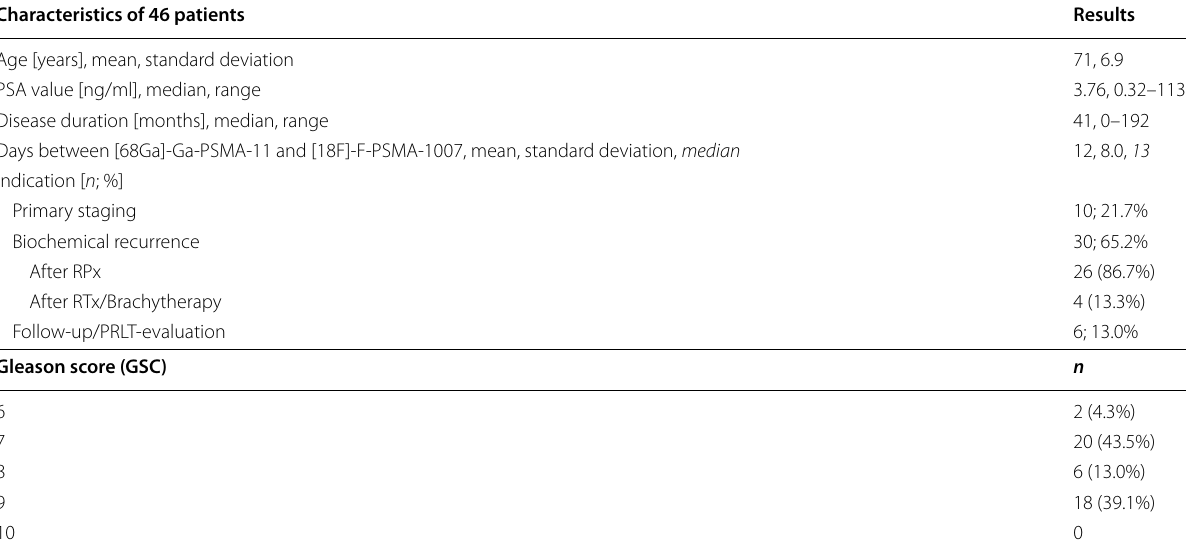
RPx, radical prostatectomy; RTx, radiotherapy